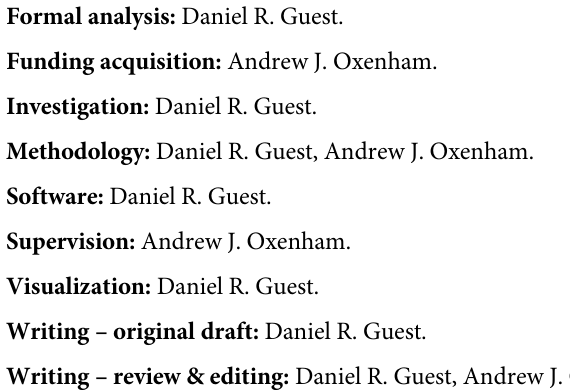
S1 Fig. Example neurograms for all masker stimuli. Neurograms generated as in Fig 1 for the ISO, GEOM, and DBL stimuli (different rows) at low frequencies (left column) and high frequencies (right column). Simulations were conducted using medium-spontaneous-rate fibers at levels of 50 dB SPL per-component for both target and masker components. TEN was not included in the